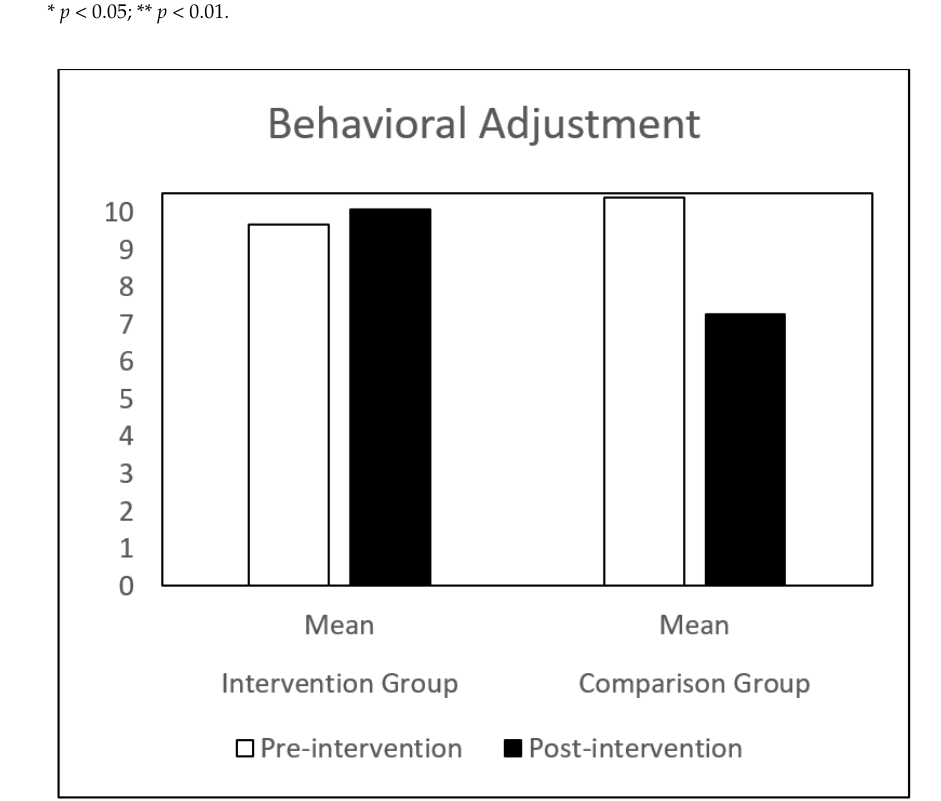
Figure 1. Behavioral Adjustment mean in IG and CG at pre- and post-intervention.